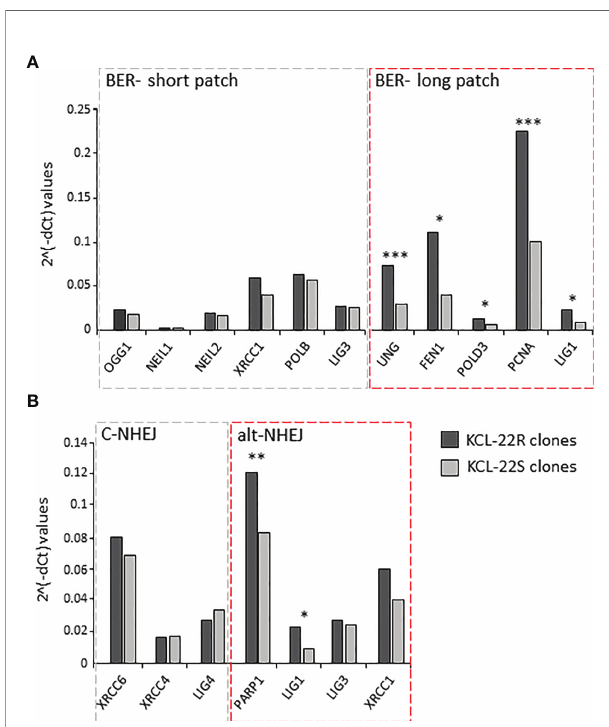
FIGURE 3 | The expression of DNA damage response and DNA repair genes putatively associated with mutagenesis in KCL-22 clones. The expression data are shown for the genes of short- and long-patch BER (A) and for DNA ligases and their functional partners - LIG1 and PARP1; LIG3 and XRCC1; LIG4, XRCC4 and XRCC6, respectively, involved in classical/c- NHEJ and alternative/alt-NHEJ (B) pathways. The expression was measured at the days of mutation acquisitions; 60-75 days postsorting. Dark gray columns represent the average gene expression for KCL-22R imatinib- resistant clones. Light gray columns represent the average gene expression in control, imatinib-naïve KCL-22S clones. The gene expression was normalized to mean Ct values for 4 control genes (B2M, GAPDH, RPLP0, HPRT1). The level of signi fi cance is indicated: *P < 0.05, **P < 0.01 and ***P <